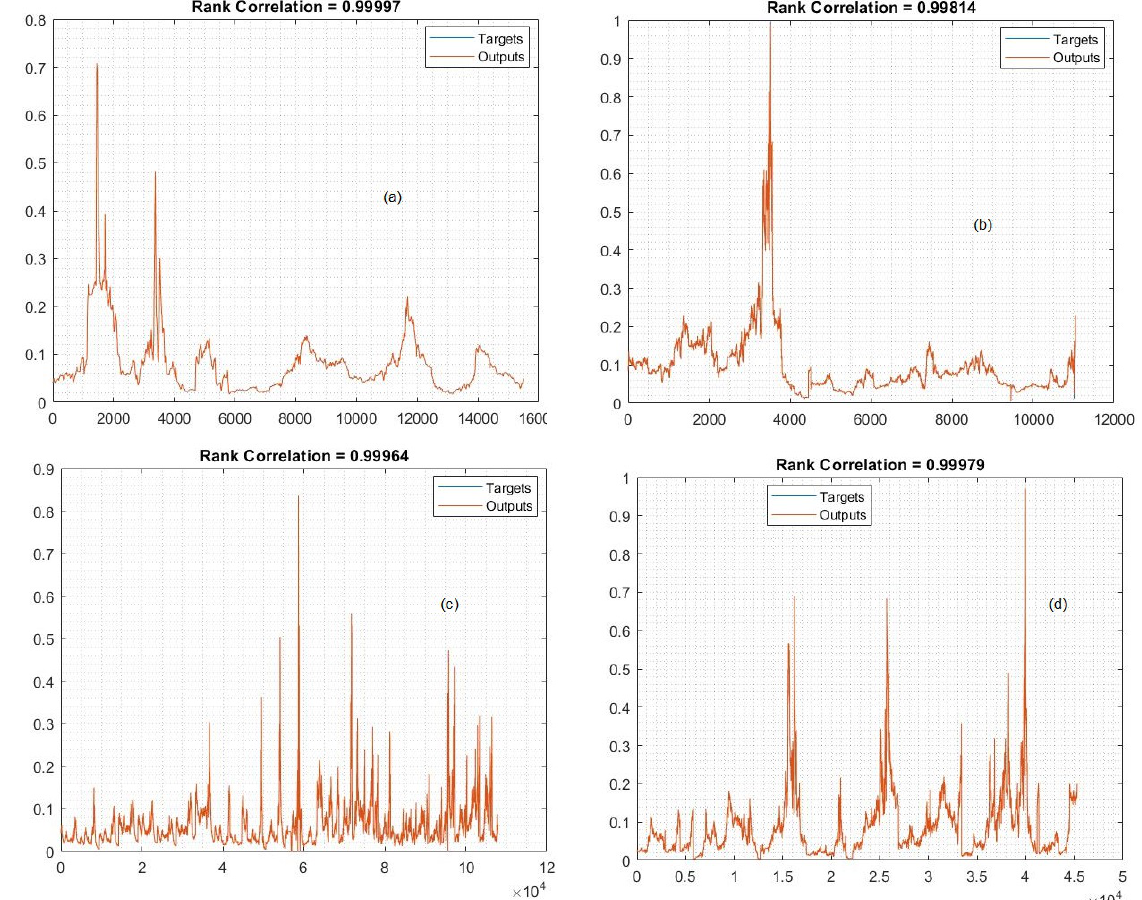
Figure 6. Prediction plot of the LSTM model in the training process ( a ) communication ( b ) energy, ( c ) financial and ( d ) industrial sectors.